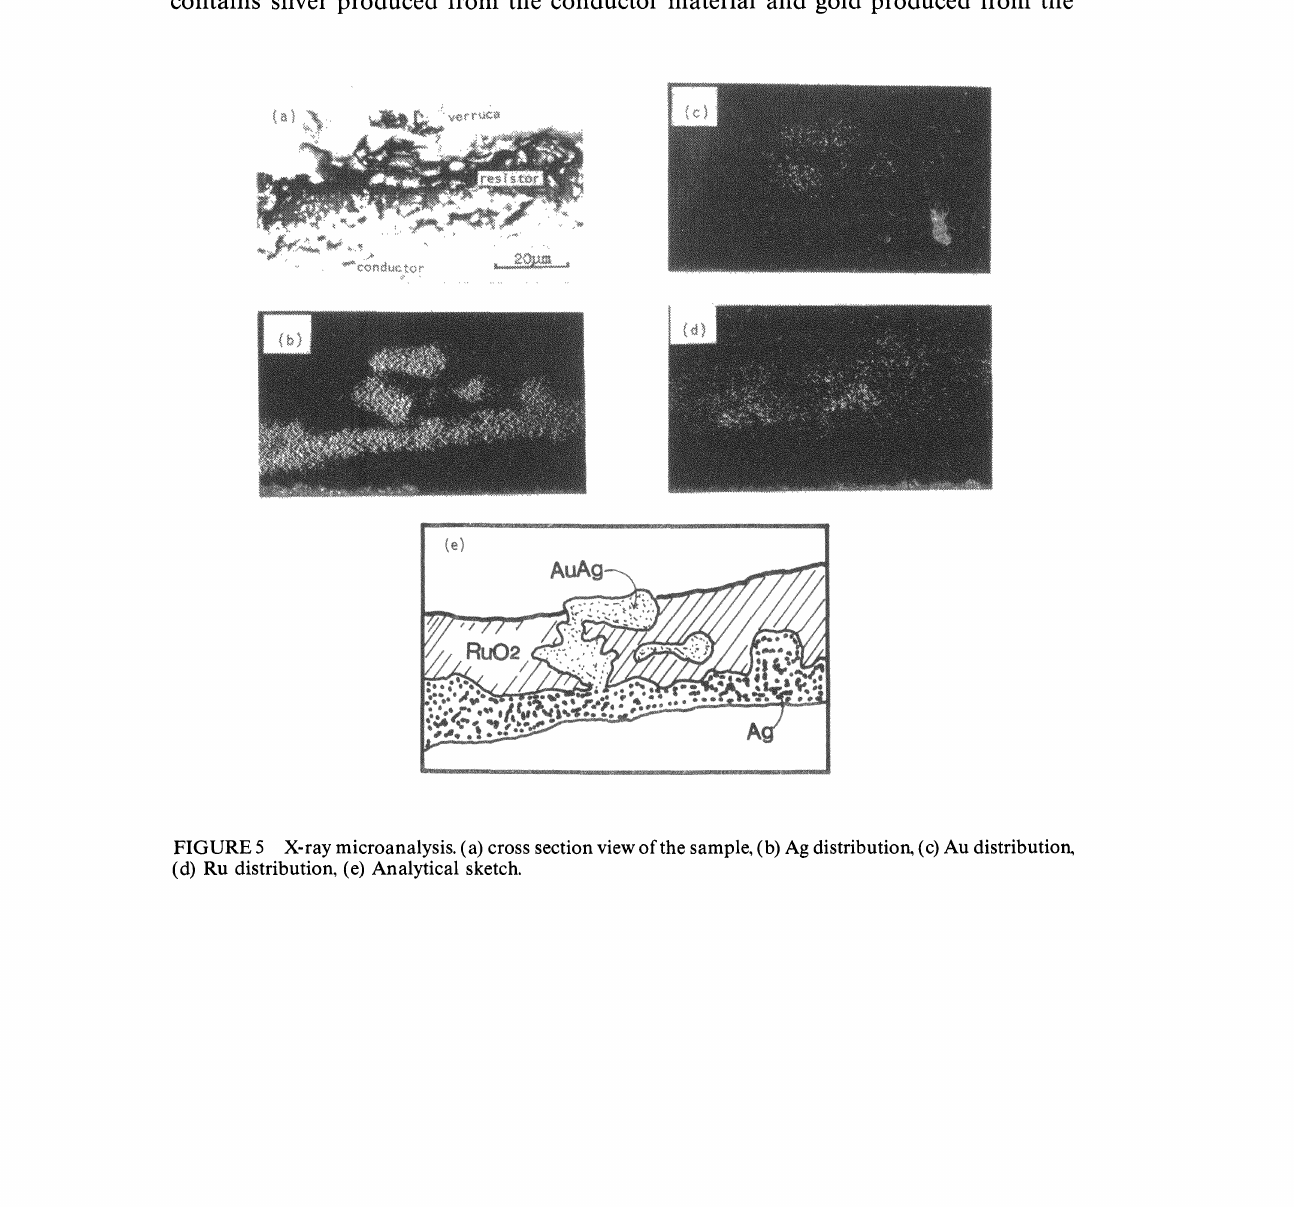
FIGURE 5 X-ray microanalysis. (a) cross section view ofthe sample, (b) Ag distribution, (c) Au distribution, (d) Ru distribution, (e) Analytical